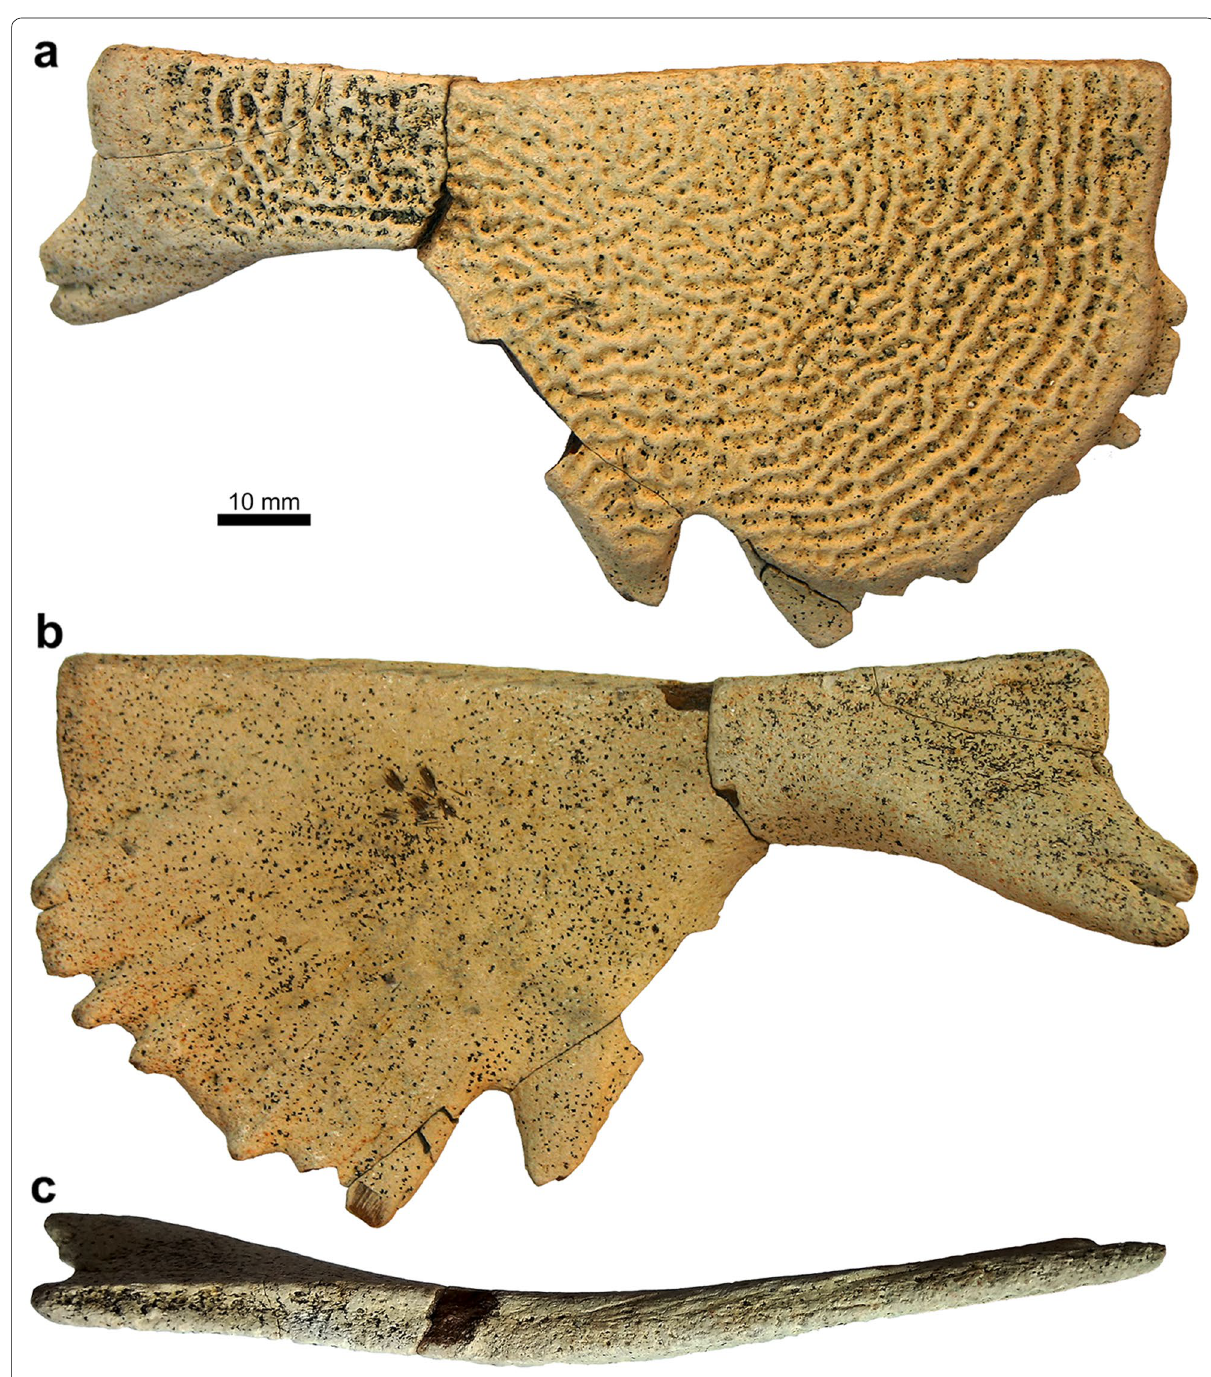
Fig. 1 Trionyx pliocenicus from Cessaniti; plastral material. Right hypoplastron (MSNC 4589) in ventral ( a ), dorsal ( b ), and anterior ( c )